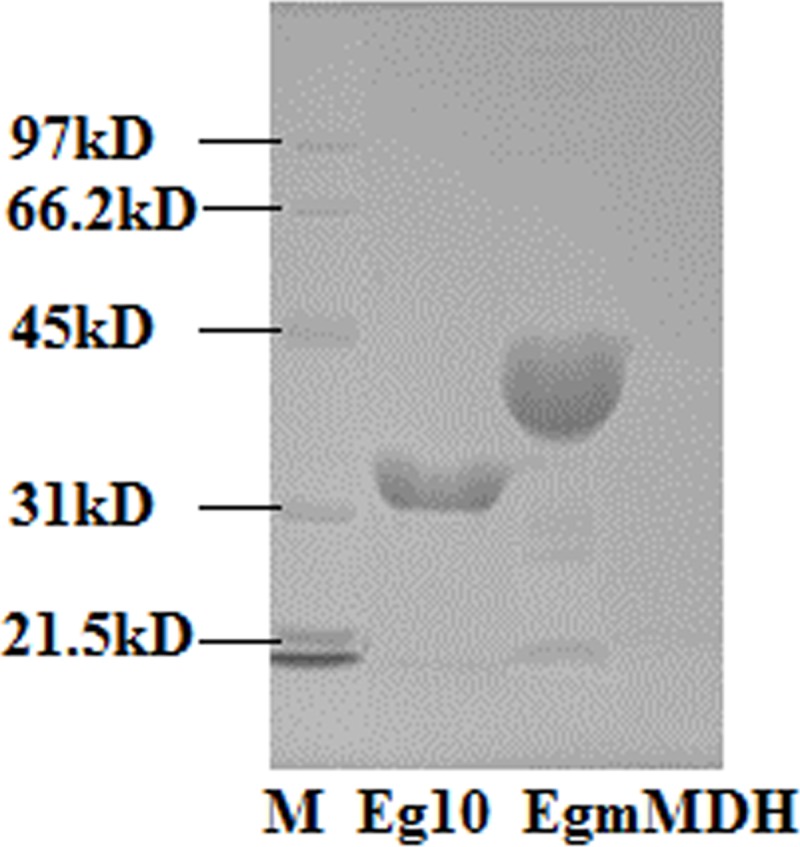
Eg10 and Eg mMDH were separated by 12% SDS-PAGE.